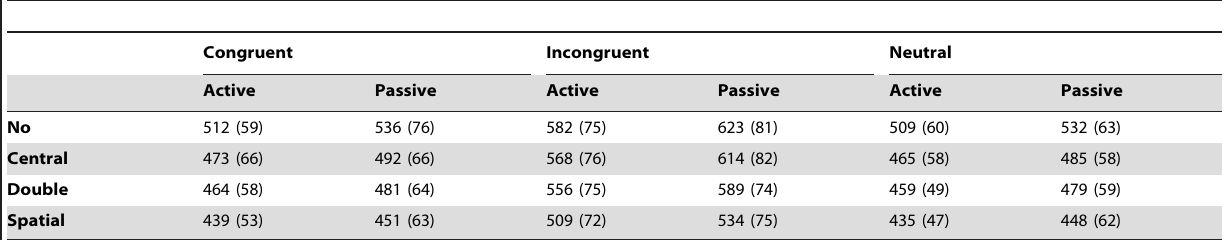
Table 2. Mean RTs (ms) and standard deviations in the different Flanker and Cue conditions.